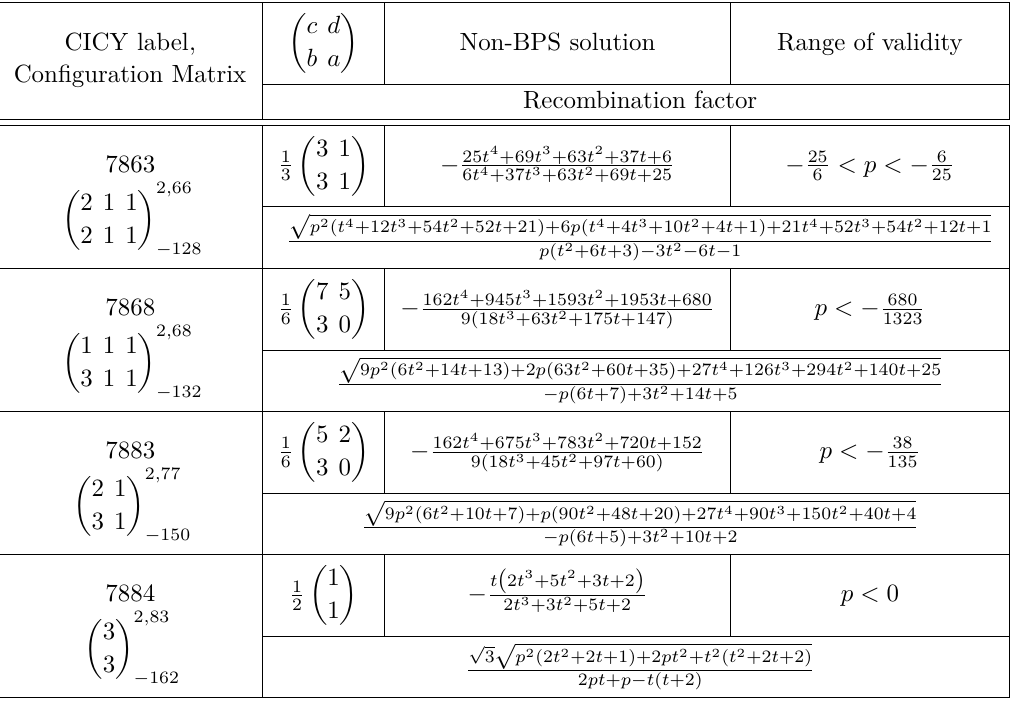
Table 11 . Non-BPS extremal black strings in one-modulus CICY models,